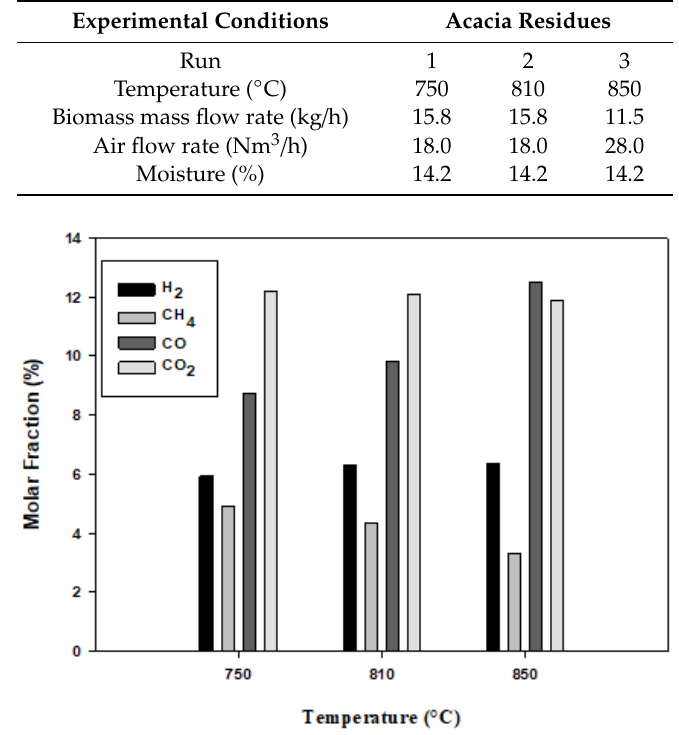
Figure 3. Molar fraction as a function of gasification temperature for the acacia residues.